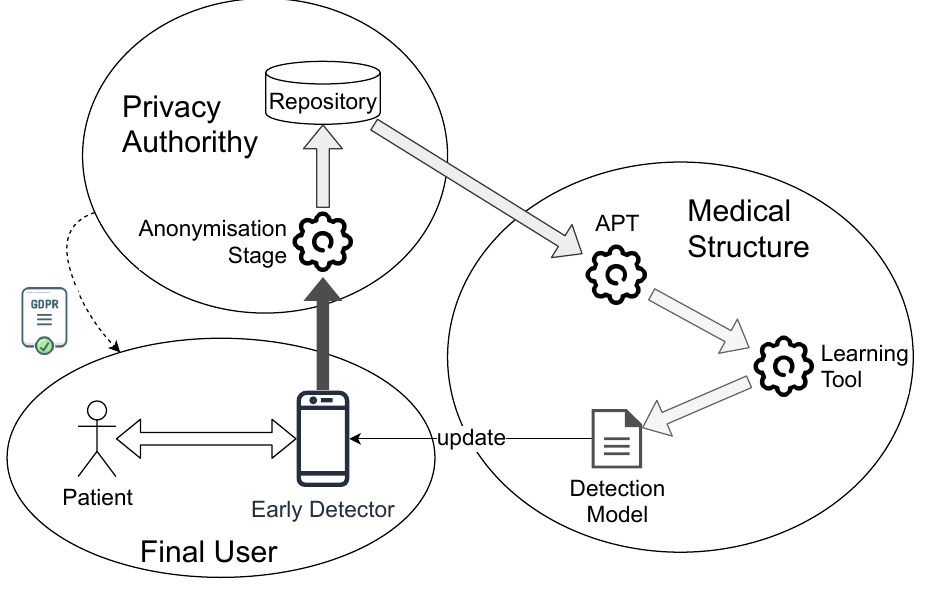
Figure 1. A supporting